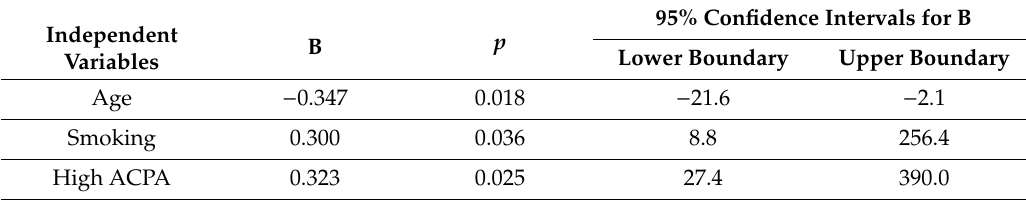
Table 3. Multiple linear regression analysis of clinical characteristics in relation to Collinsella aerofaciens OTUs (dependent variable) in RA